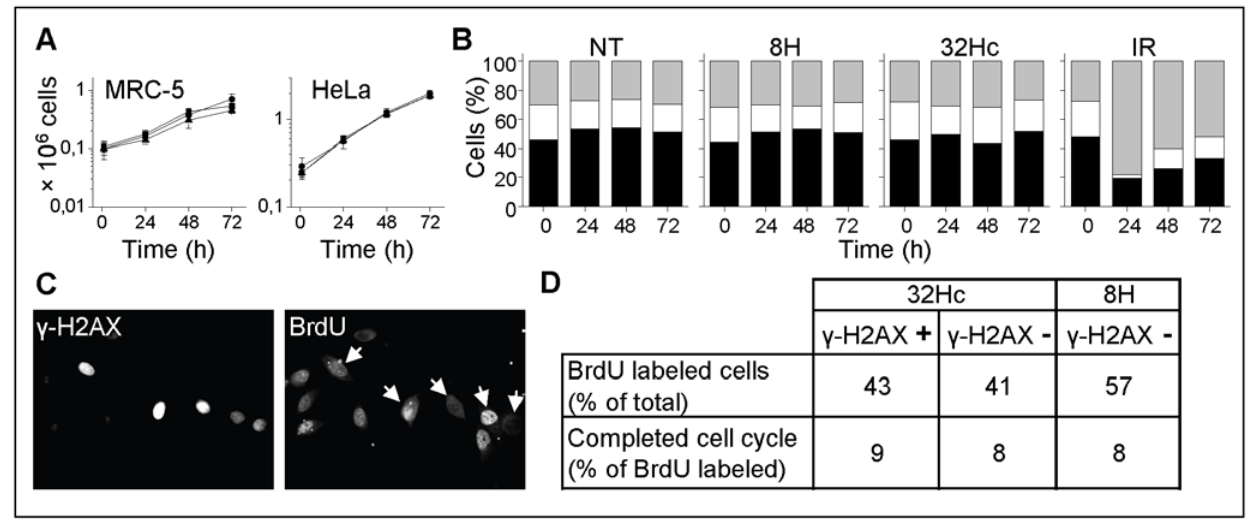
Figure 5. Effect of 32Hc on cell cycle and viability. (A) Proliferation rates of untreated (squares), 8H (circles) or 32Hc (triangles) treated MRC-5 (left panel) and HeLa (right panel) cells. Error bars represent SD. (B) Flow cytometric cell cycle analysis of untreated, 8H or 32Hc transfected and irradiated (10 Gy) MRC-5 cells. DNA was stained with propidium iodide. Cells were rediluted once after 24 h. (C) DNA synthesis was analyzed in HEp-2 cells by pulsing cells with BrdU at 24 h after 32Hc treatment: Left Panel: cells stained with c -H2AX antibodies; Right Panel: cells stained with BrdU antibodies (arrows indicate c -H2AX positive cells). (D) The cell cycle rate was estimated by microscopy analysis of HEp-2 cells’ nuclei pulsed with BrdU 1h after transfection and grown for 24 h before fixation and c -H2AX, BrdU co-immunostaining (see material and methods). In situ measurement of DNA content and the pattern of BrdU labeling indicated cells having completed a cell cycle.